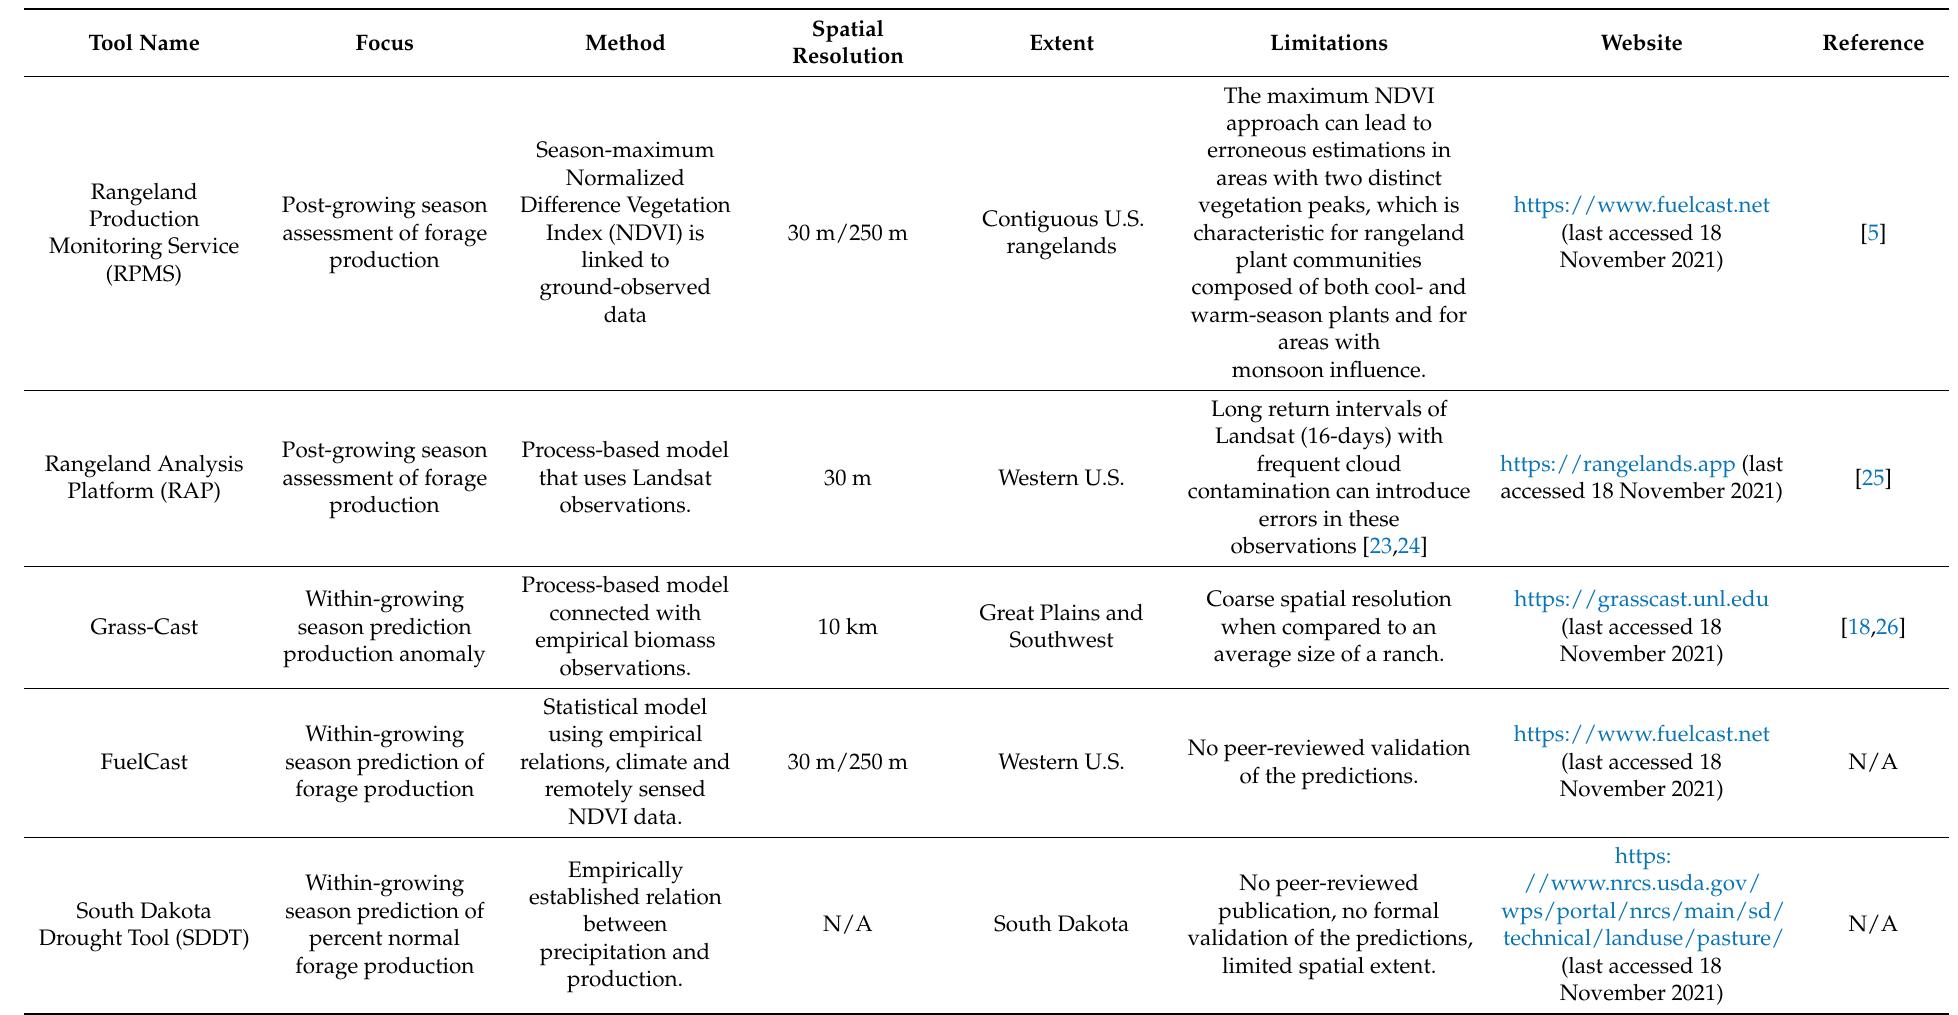
Table 1. Characteristics of large-scale rangeland forage production prediction tools in the United